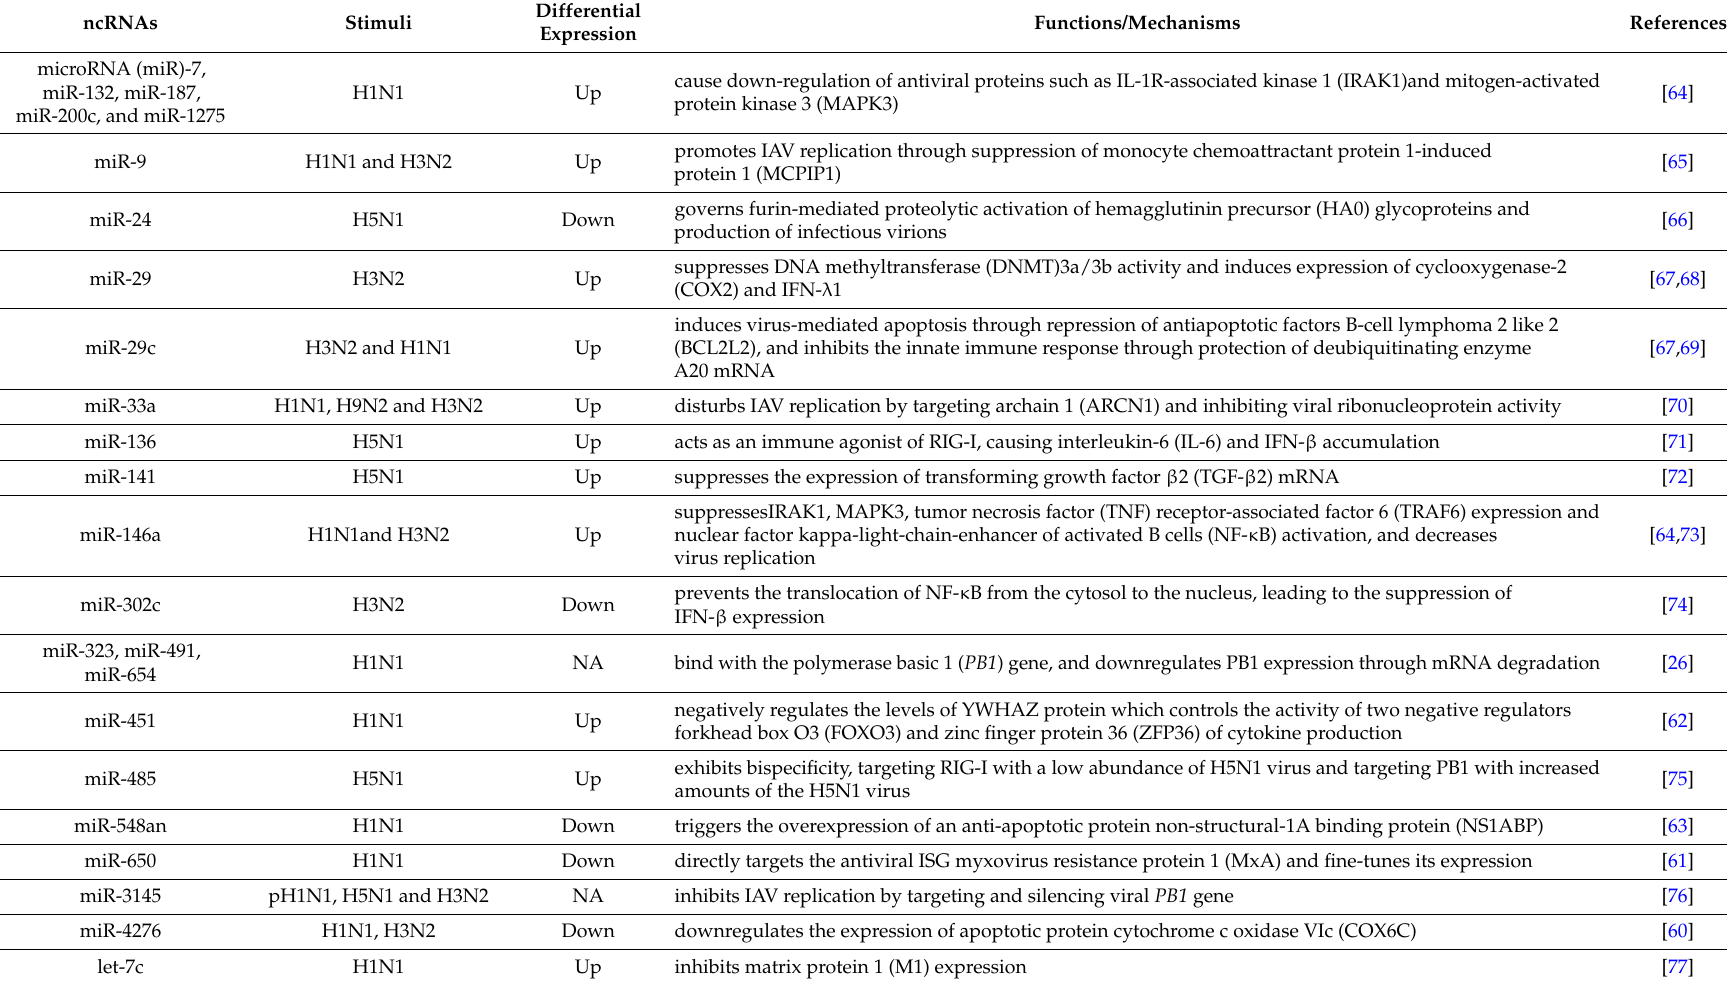
Table 1. Functional involvement of ncRNAs in regulation of the influenza virus